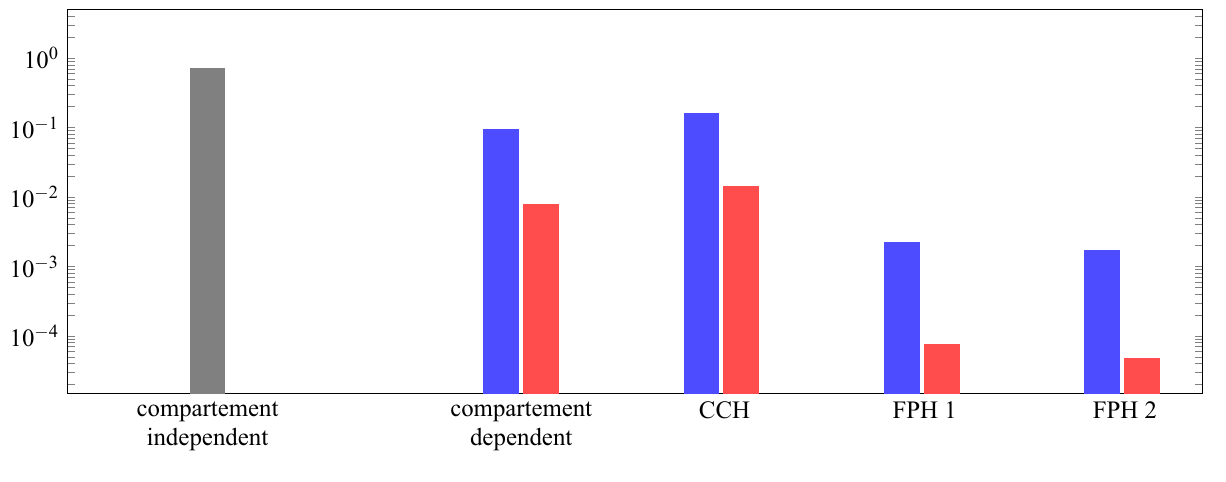
Figure 7. The data is best explained by a model where the caching rate does not depend on the compartment (grey bar at compartment independent). Prediction 1 and Prediction 2 of the Future Planning Hypotheses (FPH 1 and FPH 2 respectively) and the Compensatory Caching Hypothesis (CCH) have much lower posterior probability because they rely on compartment-dependent caching rates. Because the compartment-independent model assumes that the caching rate for each of the three compartments is 1/3, there is no difference between a bird-dependent and a bird-independent